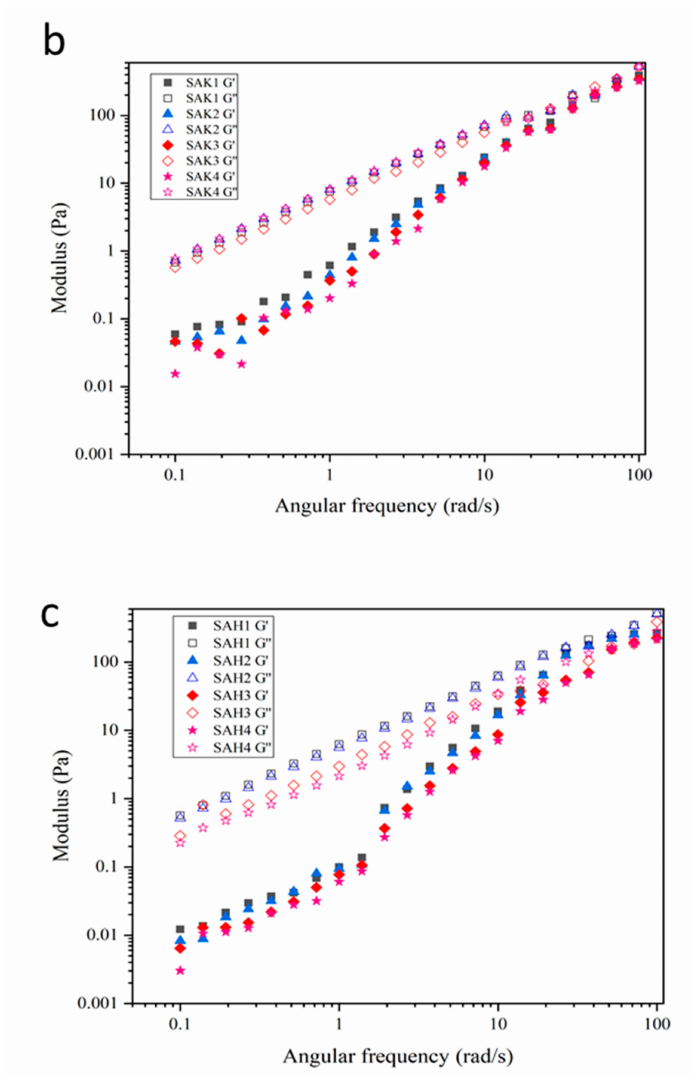
Figure 5. Frequency dependence of storage modulus (G (cid:48) ) and loss modulus (G (cid:48)(cid:48) ) of beads: ( a ) with di ff erent kaolin contents ( b ) with di ff erent rice husk powder contents ( c ) with di ff erent